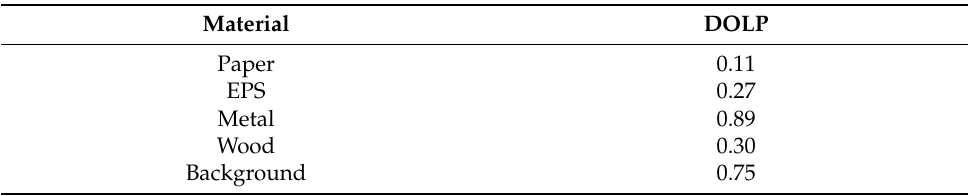
Table 3. Degree of linear polarization of the reflected illumination for each of the elements of the test plate.